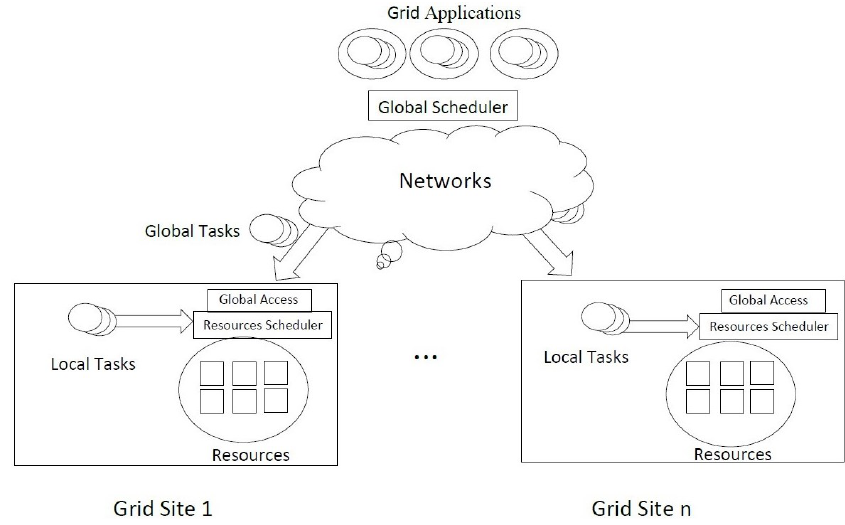
Figure 2. GFA IoT Grid Task Scheduling Architecture.